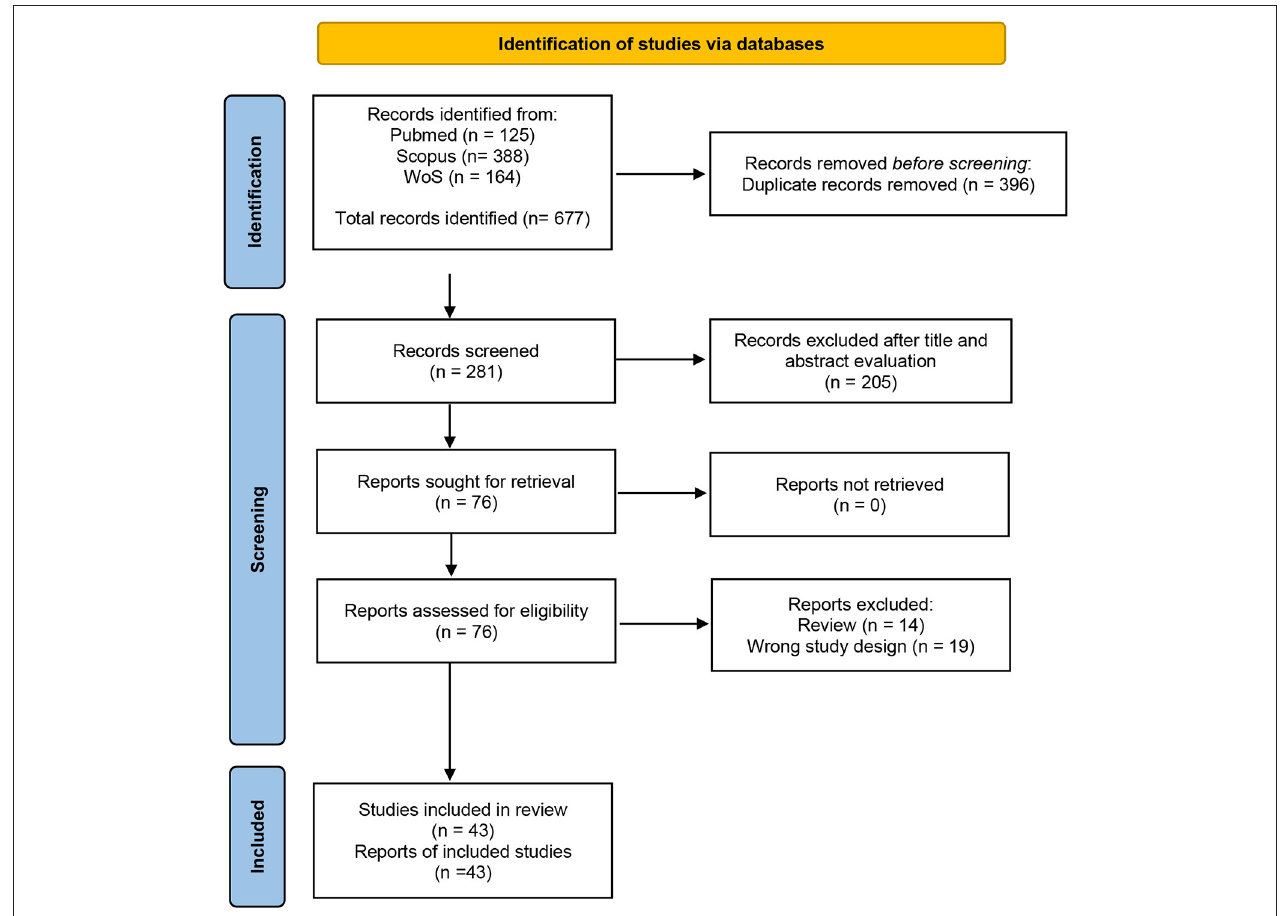
FIGURE 1 | PRISMA flow